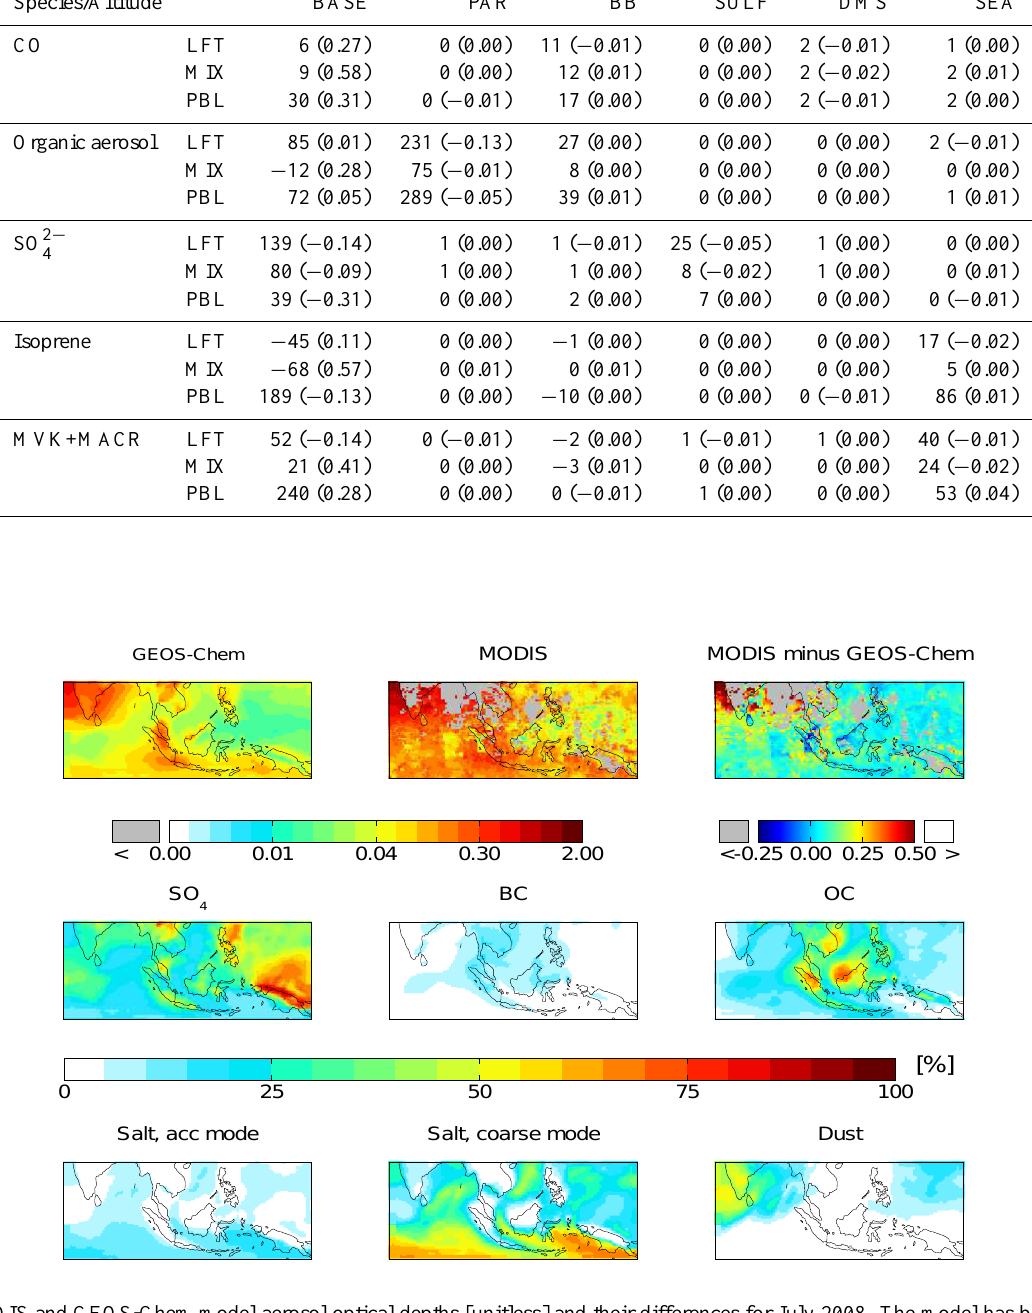
, black carbon (BC), organic aerosol (OC), 4